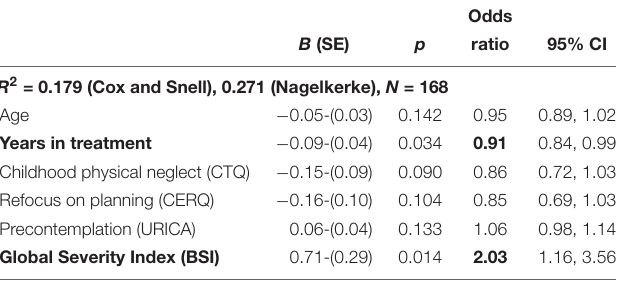
TABLE 8 | Logistic regression model to test the retrospective odds for past year SC use.